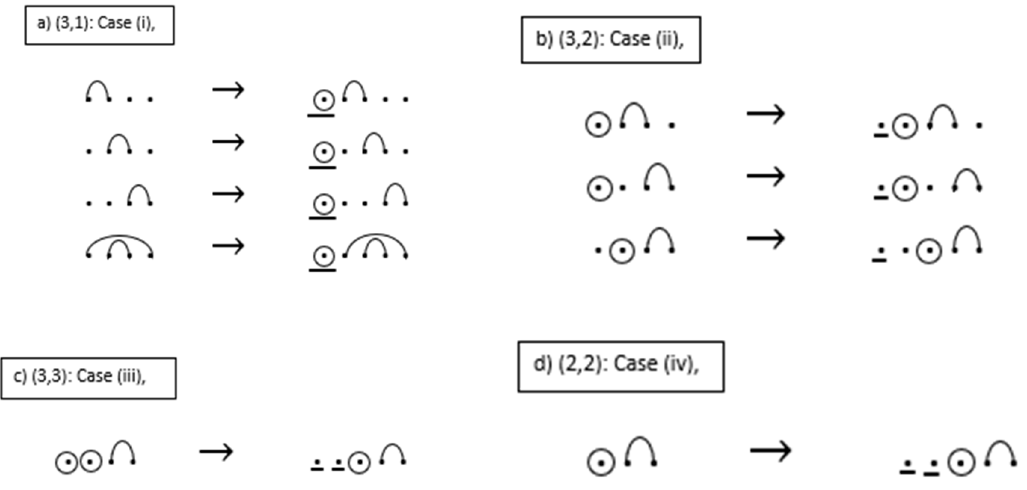
Figure 13. Example of constructing the seven sequences with mutations and wobble base pairs.